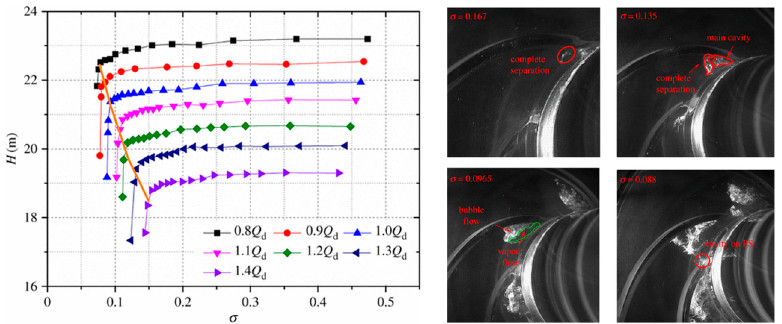
Figure 3. Cavitation performance and Cavitating flow structures of a centrifugal pump [6].